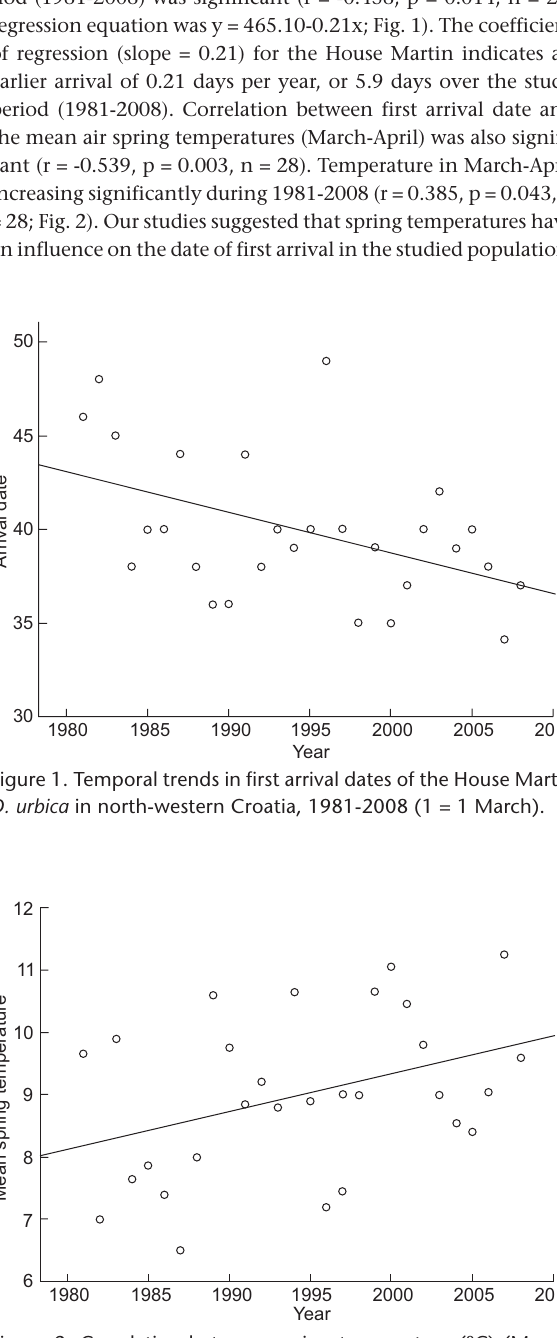
Figure 2. Correlation between spring temperature (ºC) (March- April) and year (1981-2008) in north-western